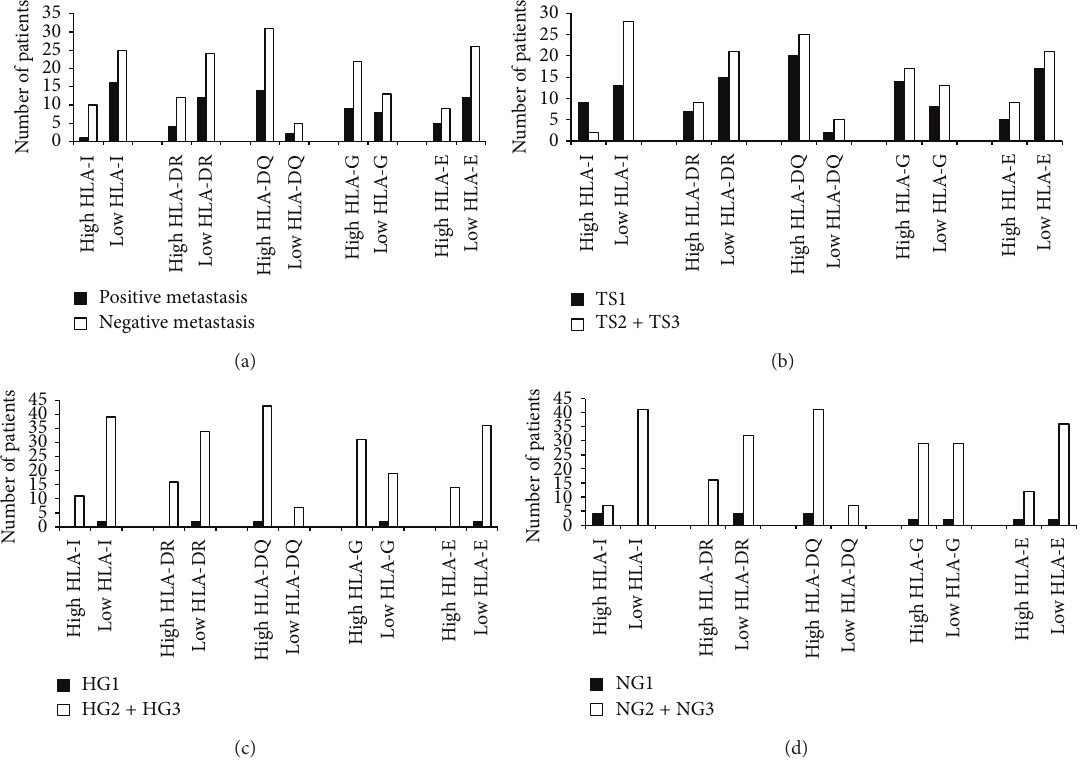
Figure 3: Quantitative immunohistochemical expression of HLA class Ia (-A, -B, and -C), HLA class II (DR and DQ), and HLA class Ib (HLA-G and HLA-E) in the 52 patients with invasive ductal carcinoma, associated with (a) metastases in axillary lymph nodes. 𝜒 2 test: HLA class Ia ( 𝑃 = 0.2830 ; 𝑃 > 0.05 ); HLA-II DR ( 𝑃 = 0.3010 ; 𝑃 > 0.05 ) and HLA-II DQ ( 𝑃 = 0.6894 ; 𝑃 > 0.05 ). HLA-G ( 𝑃 = 0.9512 ) and HLA-E ( 𝑃 = 0.3963 ; 𝑃 > 0.05 ), (b) tumor size TS1 ( < 2cm), TS2 (2 to 5 cm), TS3 ( > 5cm). 𝜒 2 test: HLA-Ia ( 𝑃 = 0.0683 ; 𝑃 < 0.05 ); HLA-DR ( 𝑃 = 1.000 ; 𝑃 > 0.05 ); HLA-DQ ( 𝑃 = 0.4420 ; 𝑃 > 0.05 ); HLA-G ( 𝑃 = 0.5801 ) and HLA-E ( 𝑃 = 0.1826 ; 𝑃 > 0.05 ), (c) histological grade (HG). 𝜒 2 test: HLA-Ia ( 𝑃 = 0.0062 ; 𝑃 < 0.05 ); HLA-DR and HLA-DQ (resp., 𝑃 = 1.000 ; 𝑃 > 0.05 ); HLA-G ( 𝑃 = 0.2695 ) and HLA-E ( 𝑃 = 0.7070 ; 𝑃 > 0.05 ), and (d) nuclear grade (NG). 𝜒 2 test: HLA-Ia ( 𝑃 = 0.0071 ; 𝑃 < 0.05 ); HLA-DR ( 𝑃 = 0.5621 ), HLA-DQ ( 𝑃 = 1.000 ; 𝑃 > 0.05 ). HLA-G ( 𝑃 = 0.4086 ) and HLA-E ( 𝑃 = 0.0661 ); 𝑃 > 0.05